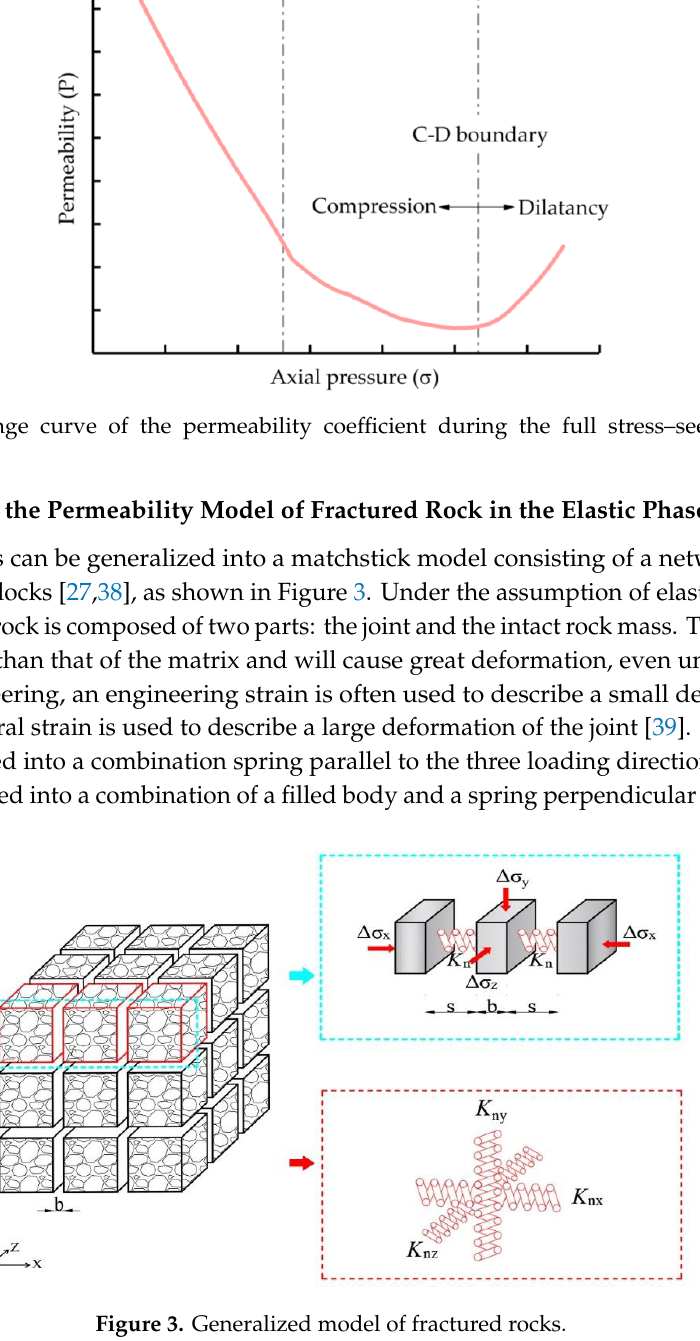
Figure 3. Generalized model of fractured rocks.